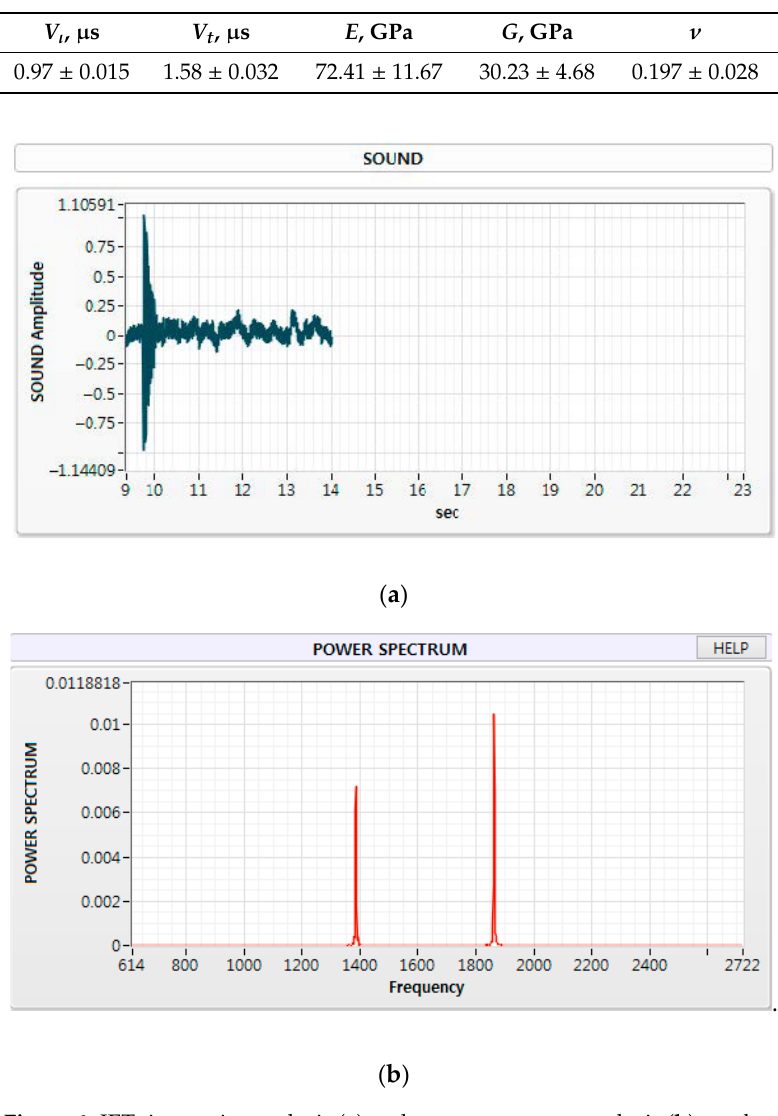
Table 2. Test results of E , G and ν in UPET.